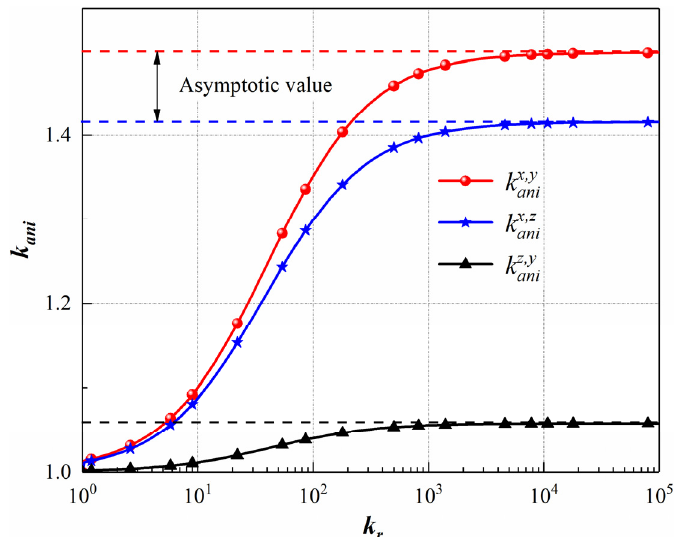
Figure 11. The variations of ani k with k r in different directions at 0.92